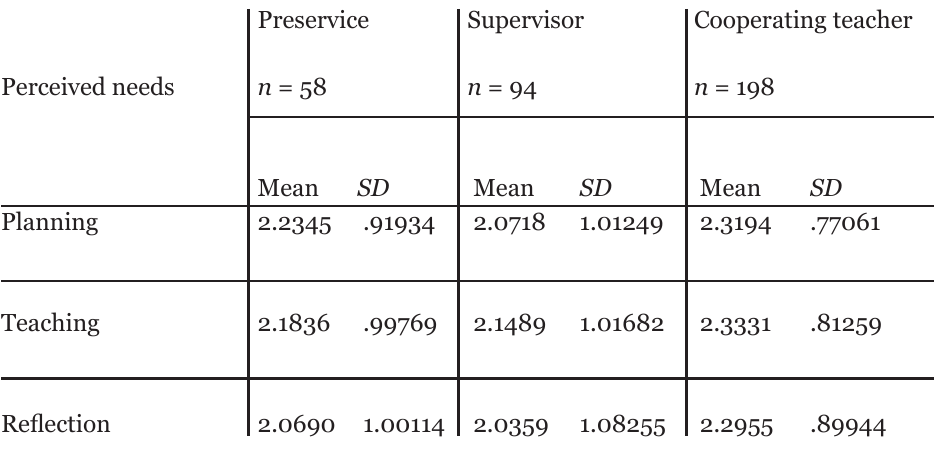
Perceived Needs of the Three Groups Using the E-Portfolio